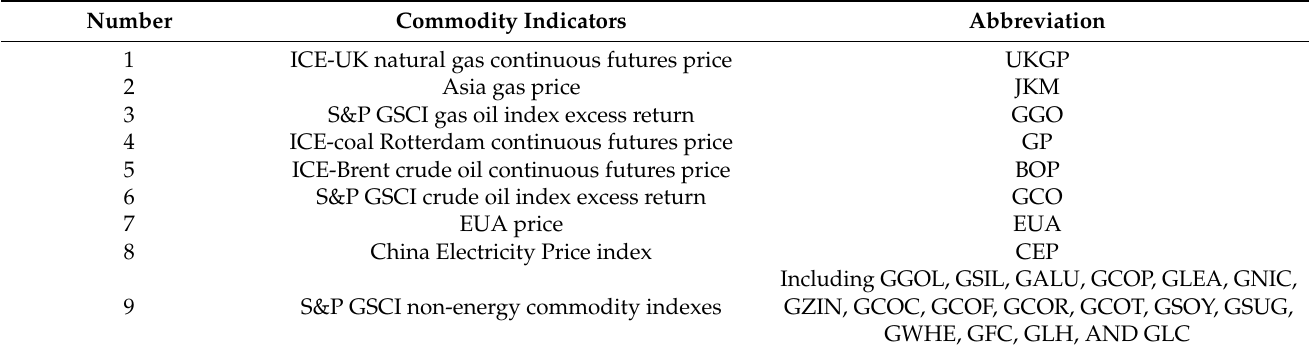
Table 3. Description of commodity